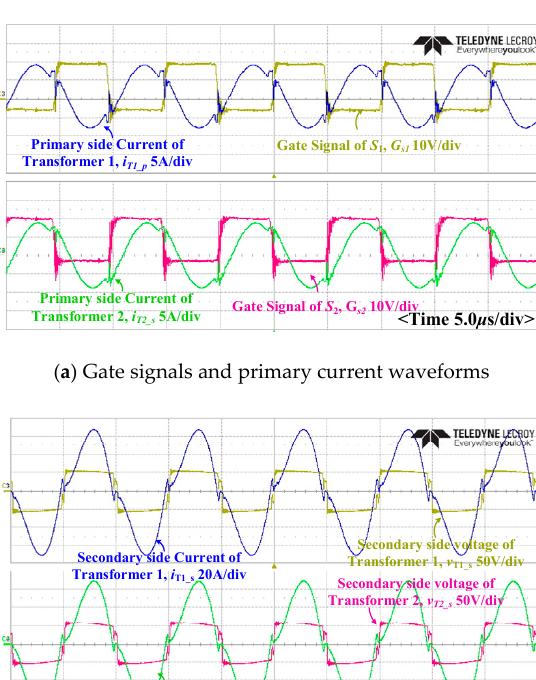
Figure 20. Experimental results of Switching Pattern 4.